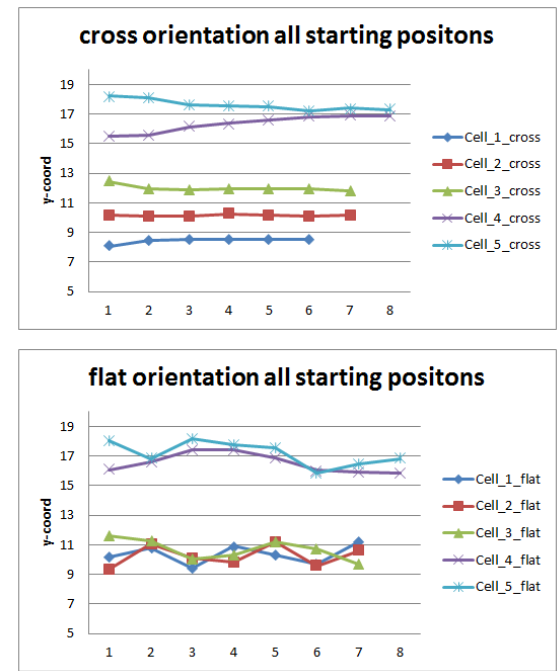
Fig.5 . For cutting position 75 + k.100 μm and each cell starting positions we illustrate the different behaviour of y-coordinate changes for cross and flat starting orientation.